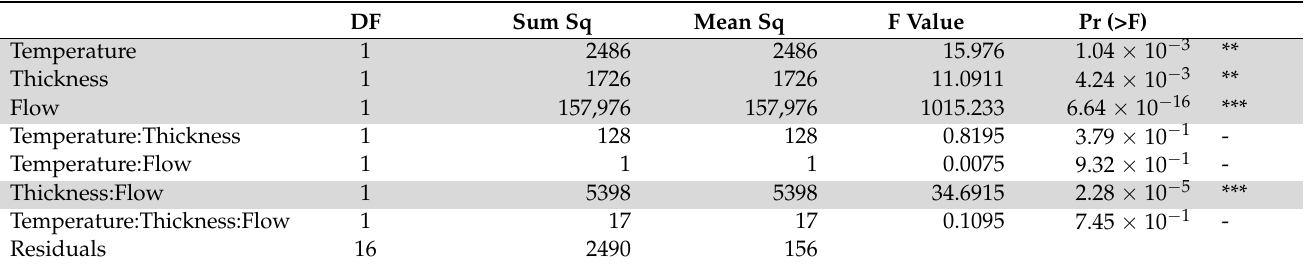
Table 15. Statistical significance of the effects of the printing parameters and their interactions on samples flexural